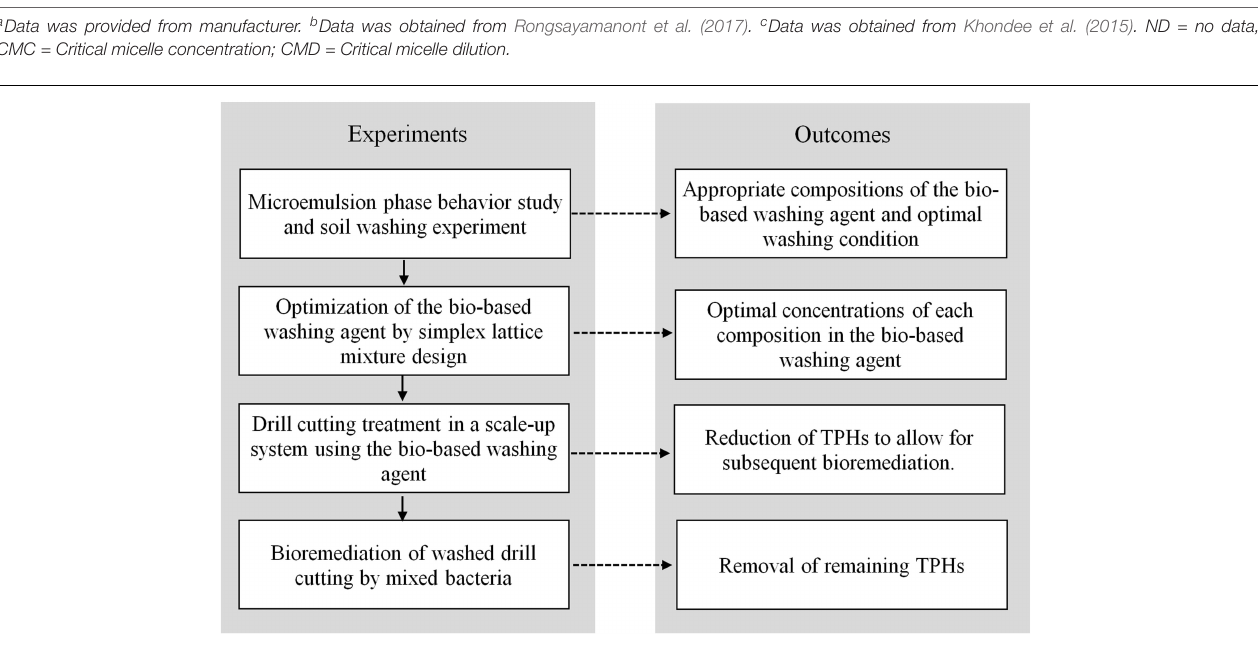
were measured by a spinning drop tensiometer (SVT 20, Dataphysic